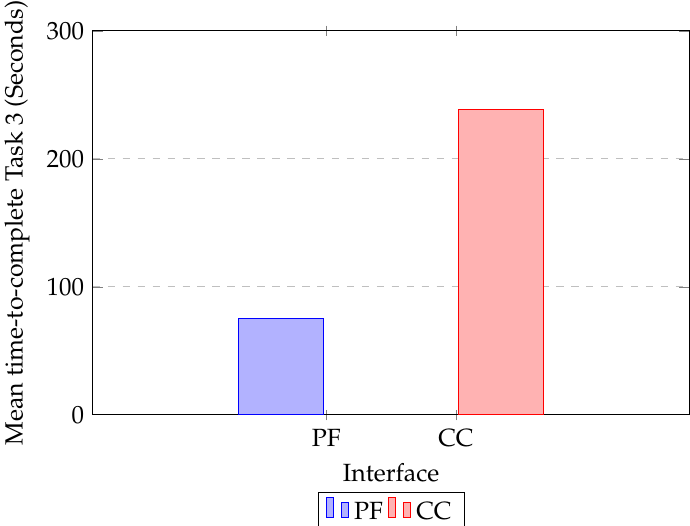
Figure 17. Mean time-to-complete Task 3 using Proposed Framework (PF) and CloudCompare